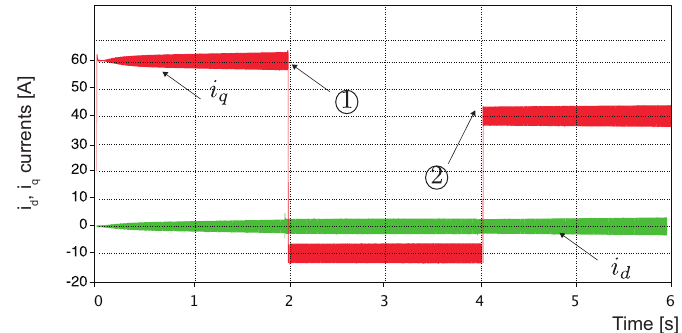
Figure 15. Electric drive performance i d i q during torque demand